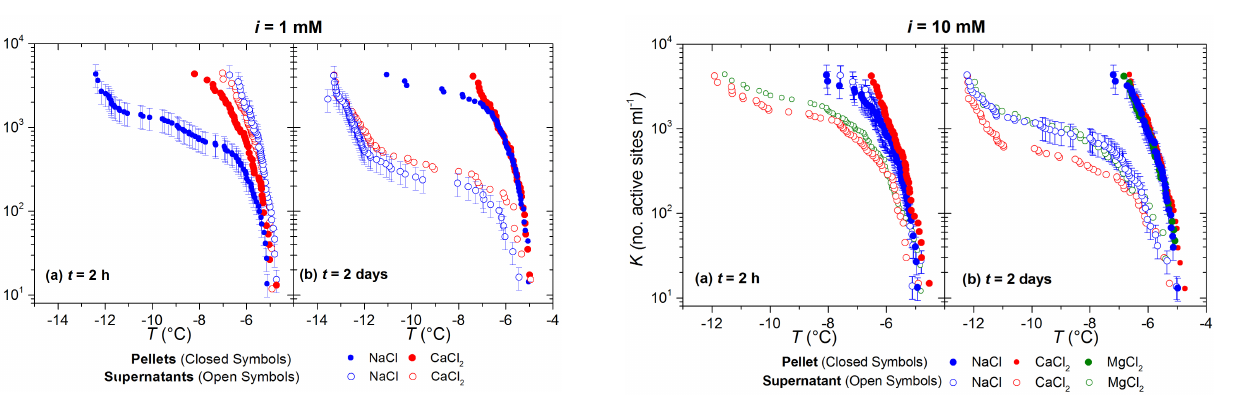
Figure 4. Effect of increasing ionic strength to 10mM on the up- take of P-INPs to the clay surface. The activities of the clay (closed symbols) and the supernatant (open symbols) after contact times of (a) 2h and (b) 2 days are illustrated. After 2h, the extent of adsorp- tion is observed to be greater than the case of when an ionic strength of 1mM is used (Fig. 3a). On increasing the contact time adsorption continues to proceed, where it can be seen that after 2 days, greater than 90% of the protein is adsorbed to the clay pellet (b)